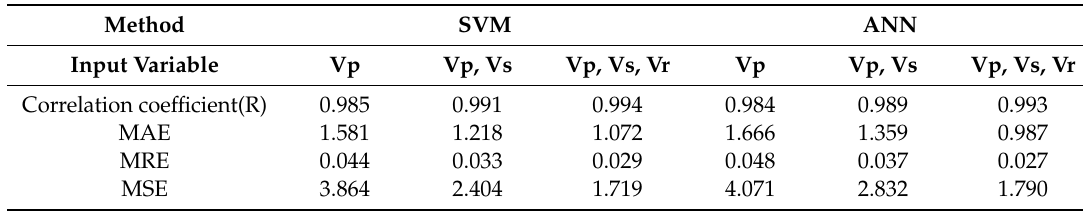
Table 11. SVM and ANN model prediction accuracy.